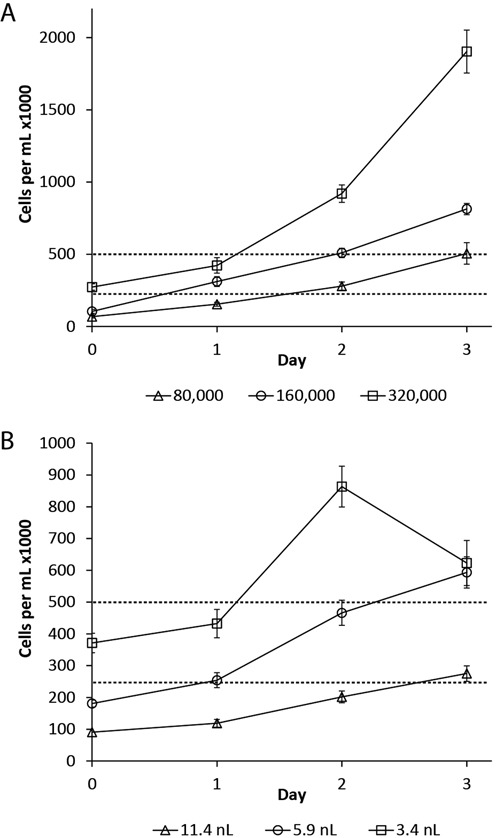
Comparison of the growth rate of Jurkat cells in bulk cultures (A) with encapsulated Jurkat cells (B) seeded at similar effective cell concentrations. Growth rates of Jurkat T cells in 3.4 and 5.9 nl droplets compare favorably with bulk cell cultures at equivalent starting cell concentrations of 80 000 to 320 000 cells per ml. However, the smallest droplets (squares) do not have adequate nutrients to maintain larger colonies after two days. The large 11.4 nl droplets (triangles) result in extremely slow growth rates. As a result, 5.9 nl droplets (circles) were selected for subsequent experiments. Mean ± standard error shown. Horizontal dashed lines at 250 000 and 500 000 cells/ml provide a visual guide for comparing the two plots.